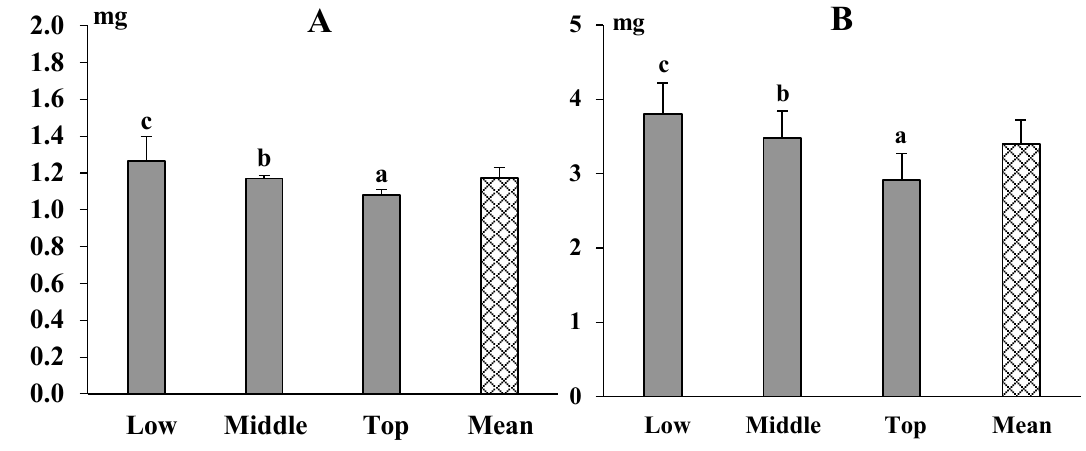
Fig. 4 The dry mass of a single anther ( A ) and the mass of produced pollen per flower ( B ) depending on the position of the flower in the inflorescence of Hyacinthus orientalis ‘Sky Jacket’ (means from